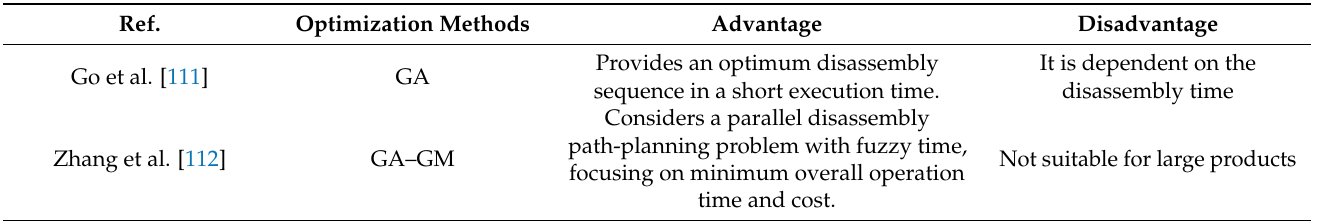
Table 8. Related works from the literature about optimization methods for disassembly process. Ref. Optimization